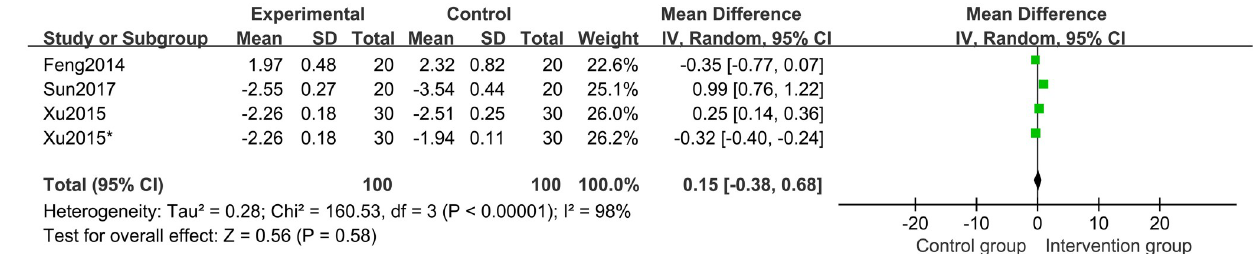
Fig 12. Forest plot of height standard deviations score (HtSDS).